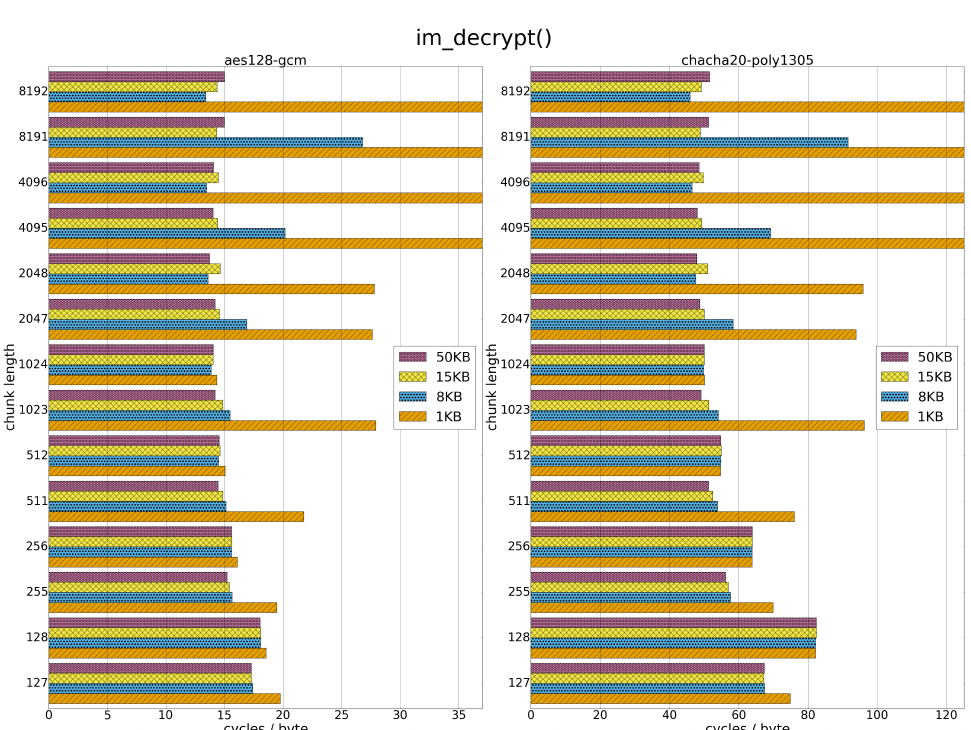
Figure 2: Performance measurements (lower is better) of the decrypt function ( im_decrypt() ) in libInterMAC for a number of chunk lengths and message lengths. Each chart shows the number of clock cycles per byte using either AES - GCM (left chart) or ChaCha20 - Poly1305 (right chart) as the internal nonce-based AE scheme. The number of clock cycles per byte, for each combination of chunk and message length (of size 1KB, 8KB, 15KB or 50KB, as indicated by four distinct label colors/patterns), is computed by taking the minimum of 25 independent averages where each average is calculated over 100 samples. AES - GCM is implemented using AES-NI and CLMUL instructions, while ChaCha20 - Poly1305 is done purely in software (cf. Section 4.4). im_decrypt() uses constant-time padding removal, cf. Section 4.6.1. Some bars for the 1KB message category are truncated to increase readability. Left chart: the value for chunk lengths of 4095/4096 or 8191/8192 are approximately 55 cycles/byte and 115 cycles/byte, respectively. Right chart: the value for chunk lengths of 4095/4096 or 8191/8192 are approximately 180 cycles/byte and 360 cycles/byte,